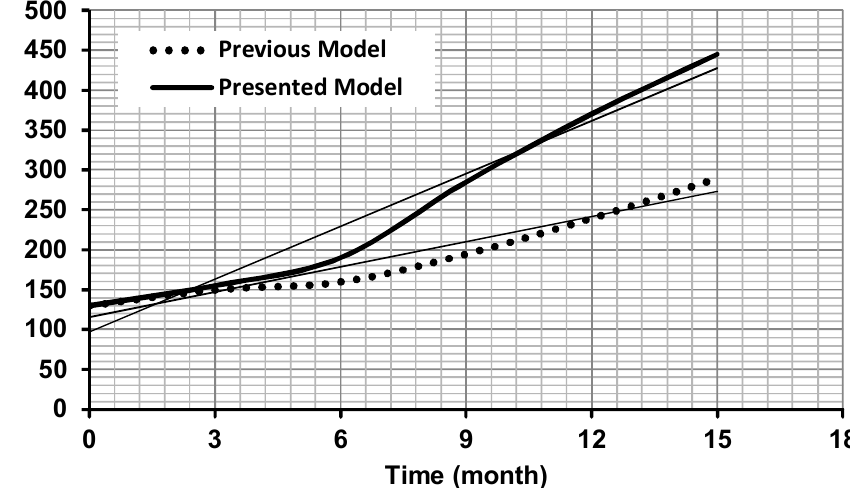
Fig. 8. Comparison between presented and previous KM implementation model for all of the characteristics in case study